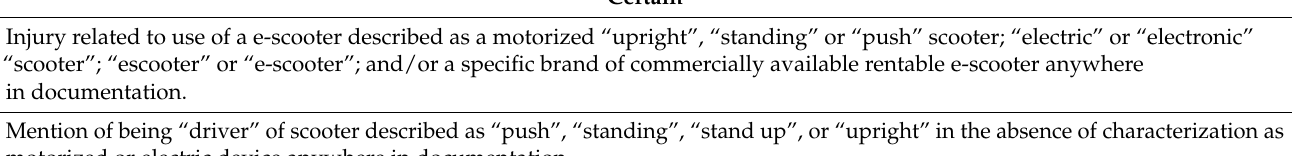
Table 1. Criteria Used to Identify and Assign Confidence to Patients with e-Scooters Injuries in Manual Review of Provider